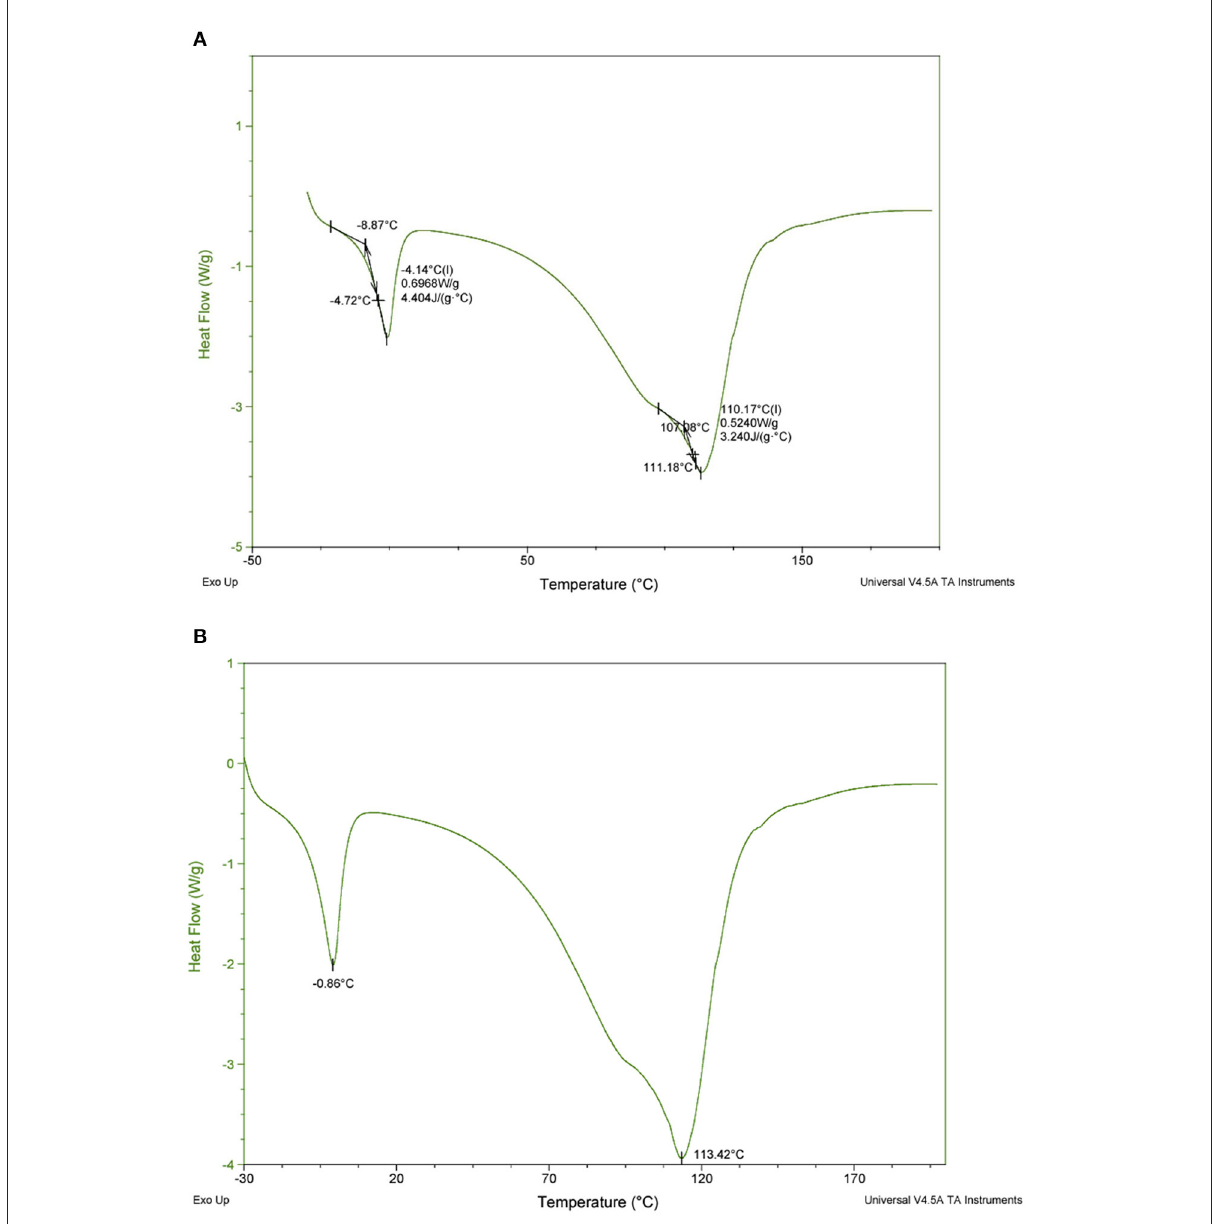
FIGURE5 DSC thermogram of pawpaw pulp showing (A) glass transition temperature and specific heat capacity, and (B) melting and thermal degradation